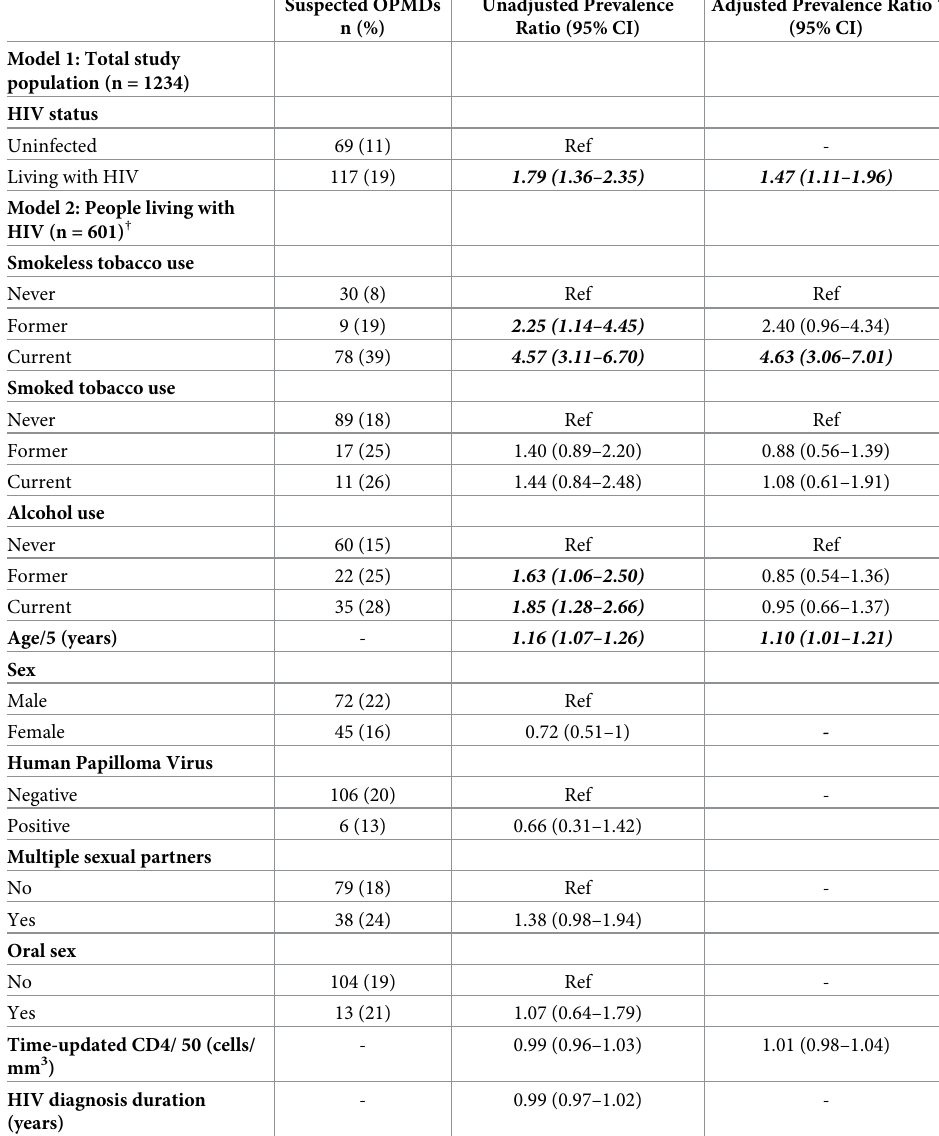
Table 2. Prevalence ratios for suspected oral potentially malignant disorders among participants recruited in an mHealth-based oral cancer screening study in Pune,